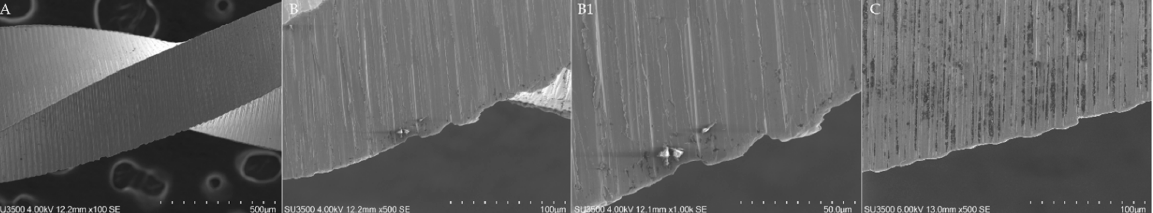
Figure 4. SEM images of the disruption of cutting edges in WOG new and used instruments. ( A ) ×100 magnification of the disrupted cutting edges in a new WOG instrument. ( B , B1 ) two different magnifications (respectively ×500 and ×1000), in which is shown the presence of disruption of cutting edges without any associated microcracks or microfracture in WOG new instrument. ( C ) Micrograph showing the disruption of cutting edge in the used WOG instrument of image ( B , B1 ), in which there has been the flattening of the cutting edges with a consequent reduction of their disruption. No microcracks or microfracture can be noted. It can be speculated that those morphological aspects arise from the machining procedures and do not have any role in the microcracks and fracture propagation.